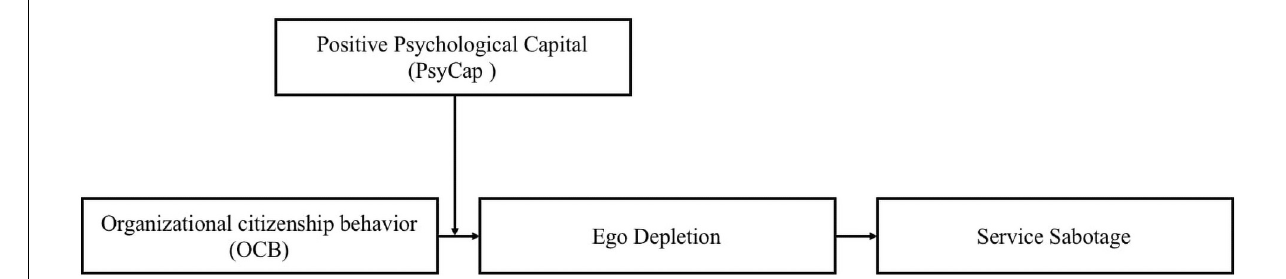
FIGURE 1 | The proposed moderated mediation